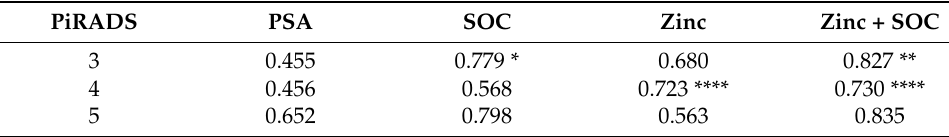
Table 8. Diagnostic performance in MRI subgroups.